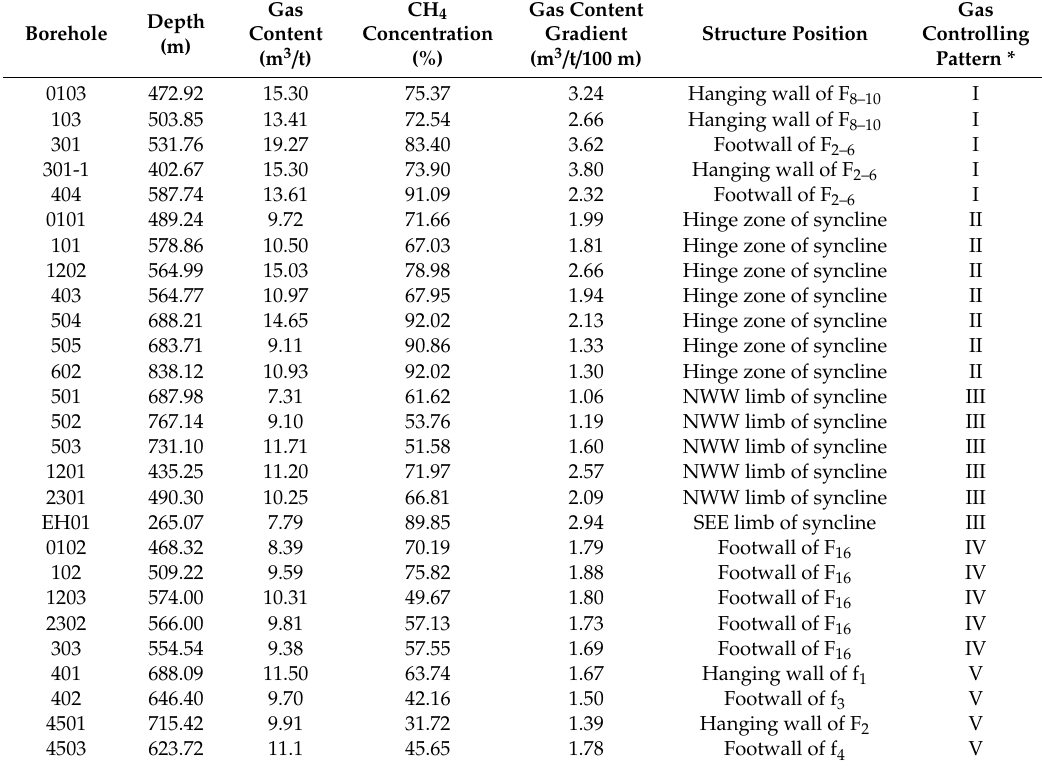
Table 2. List of gas-bearing property parameters and structure position of No. 9 coal seam.